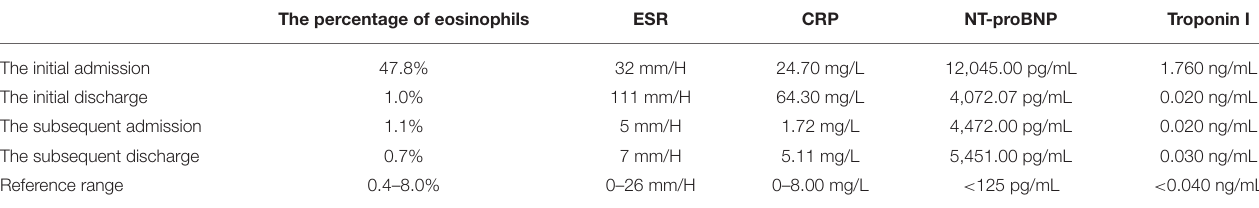
TABLE 1 | Laboratory findings during two separate hospitalizations.